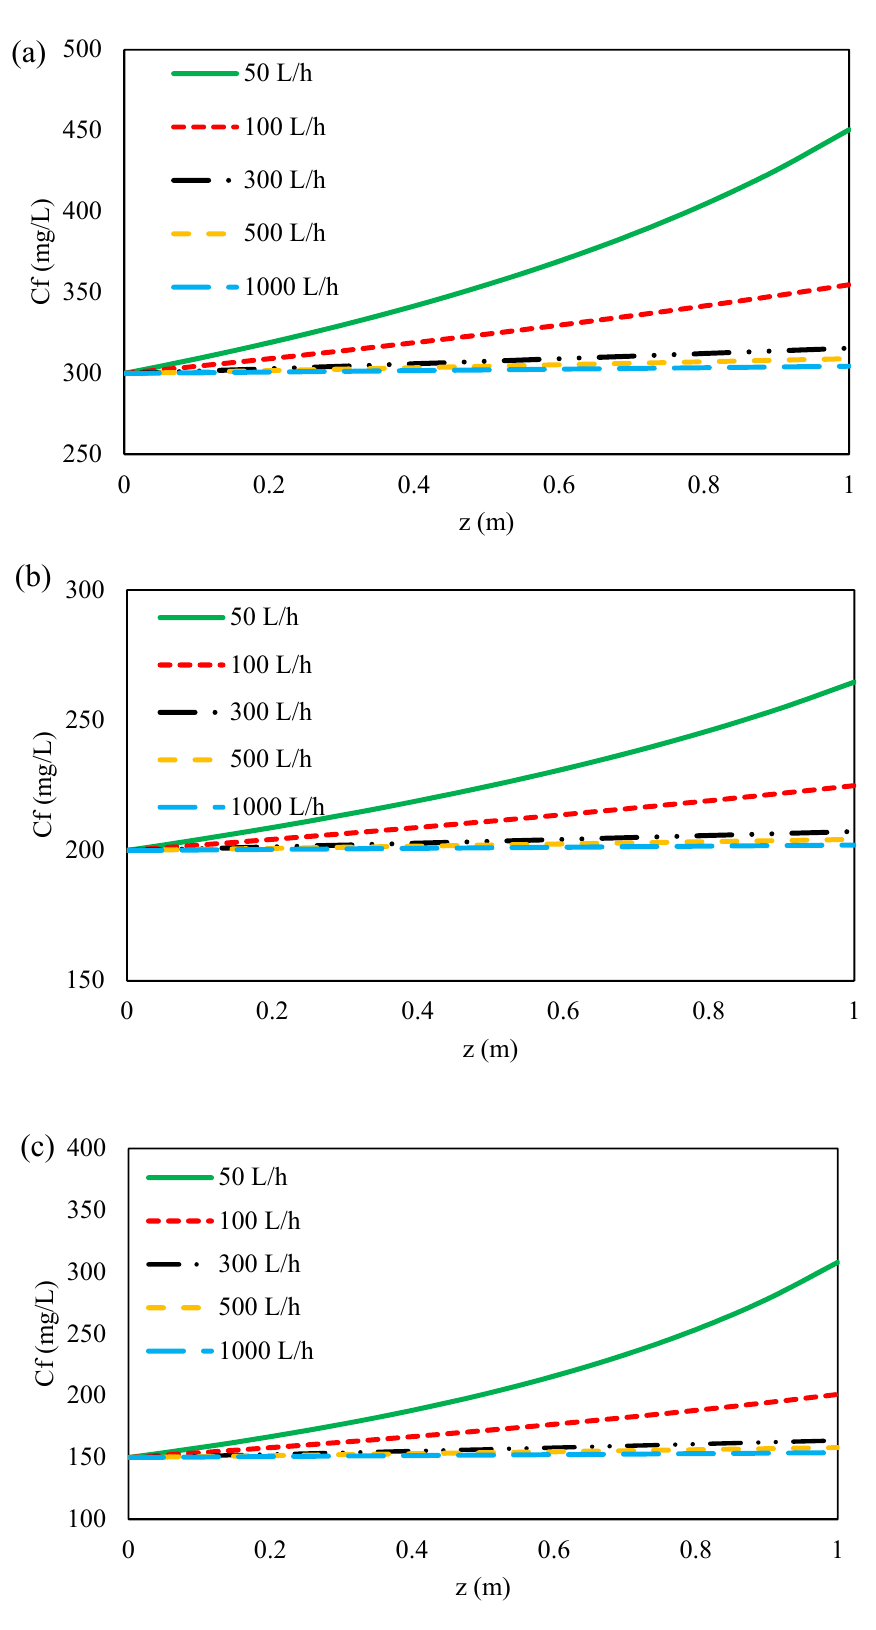
Figure 9. Ions concentration on the feed side for ( a ) formate, ( b ) acetate, ( c ) sulfate of 45 wt. % MDEA solution at different feed flow rates and 70 bar inlet feed pressure.